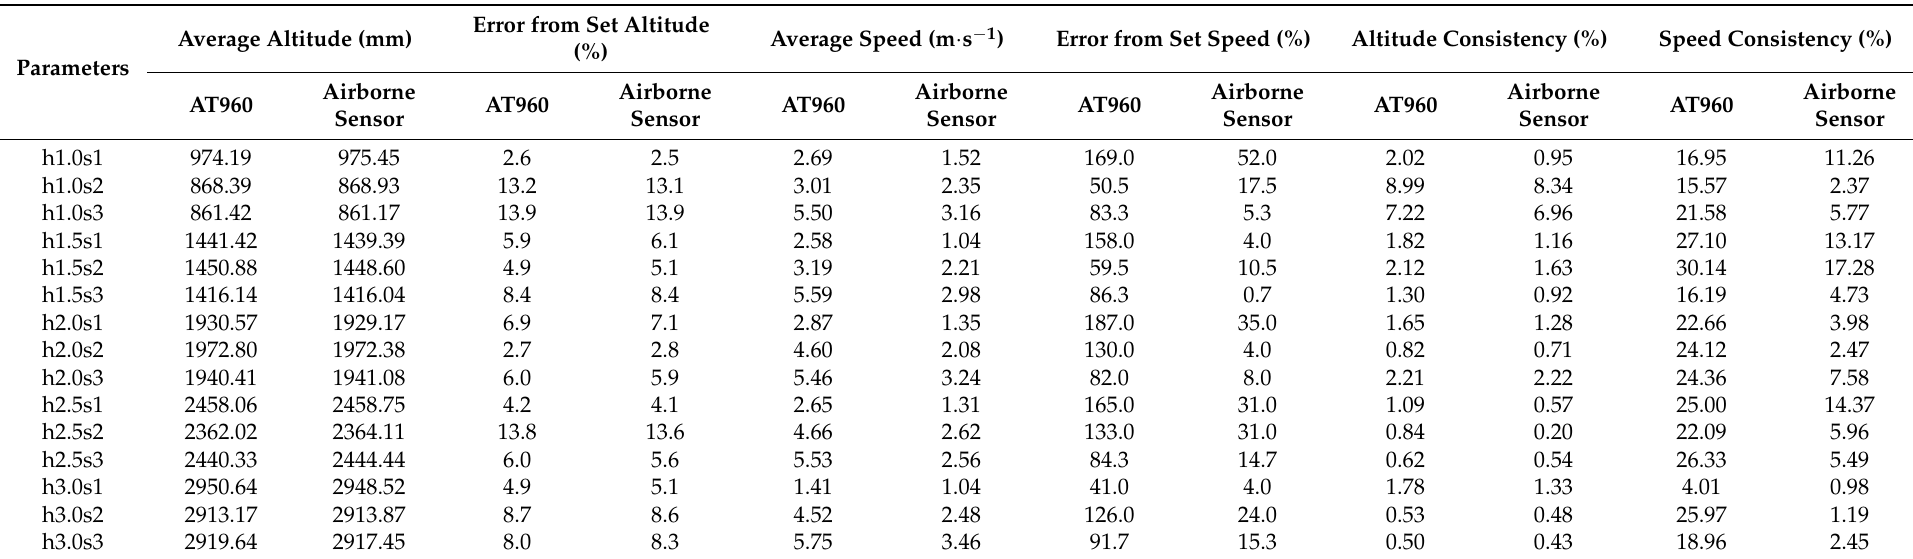
Table 4. Consistency of flight speed and